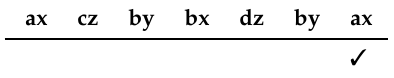
Table 10. MR-I results for end constraints